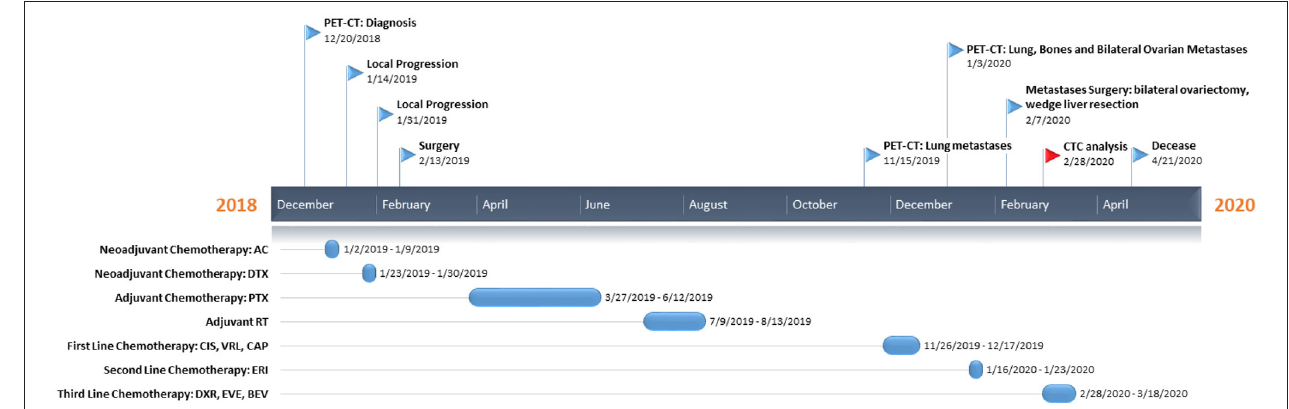
FIGURE 1 | Patient’s timeline. At the top, we reported the milestones of her clinical course, while on the bottom the treatment regimens administered to the patient. PET-CT, positron emission tomography-computed tomography; AC, adryamicin-cyclophosphamide; DTX, docetaxel; PTX, paclitaxel; CIS, cisplatin; VRL, vinorelbine; CAP, capecitabine; ERI, eribulin; DXR, doxorubicin; EVE, everolimus; BEV, bevacizumab; CTC, circulating tumor cell.